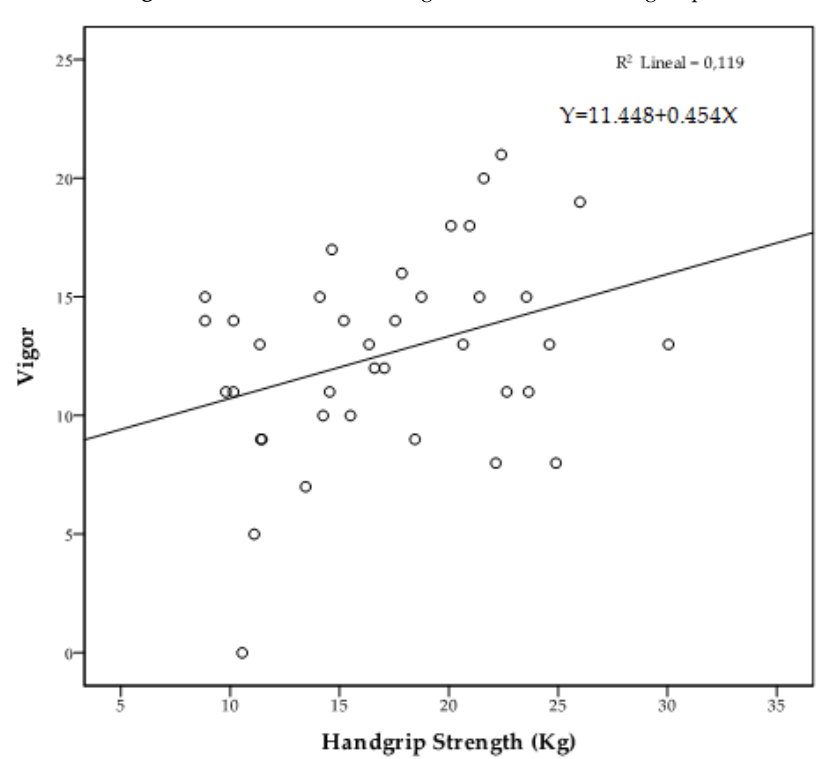
Figure 3. Scatter plot of HGS in relation to vigor.